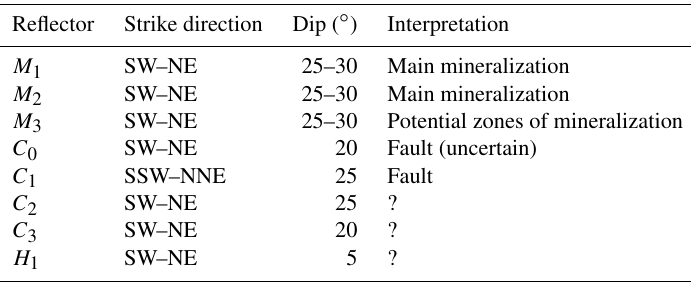
Table 4. Characteristics and interpretation of the imaged